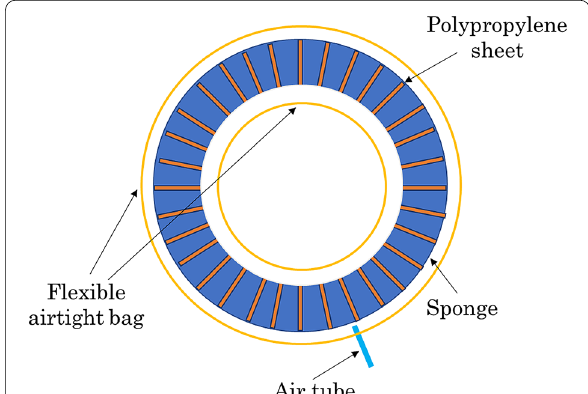
Fig. 2 Schematic illustration of a rubber-band gripper. The rubber band gripper shrinks and wraps around objects of various shapes placed in the ring by evacuating the inside air through the air